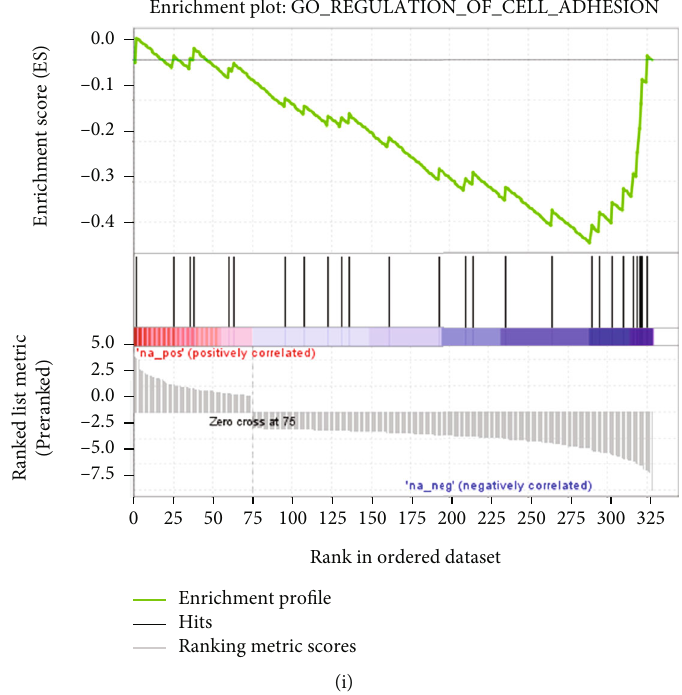
Figure 1: Identi fi cation of DEGs and their biological functions for osteosarcoma. (a) Heatmap showing 329 DEGs between osteosarcoma cells and mesenchymal stem cells. Red represents upregulated genes and green represents downregulated genes. GO including (b) biological process, (c) cell component, and (d) molecular function and (e) KEGG enrichment results depicting underlying biological functions for these DEGs. (f – i) GSEA results based on these DEGs, including cell motility, extracellular matrix, signaling receptor binding, and regulation of cell